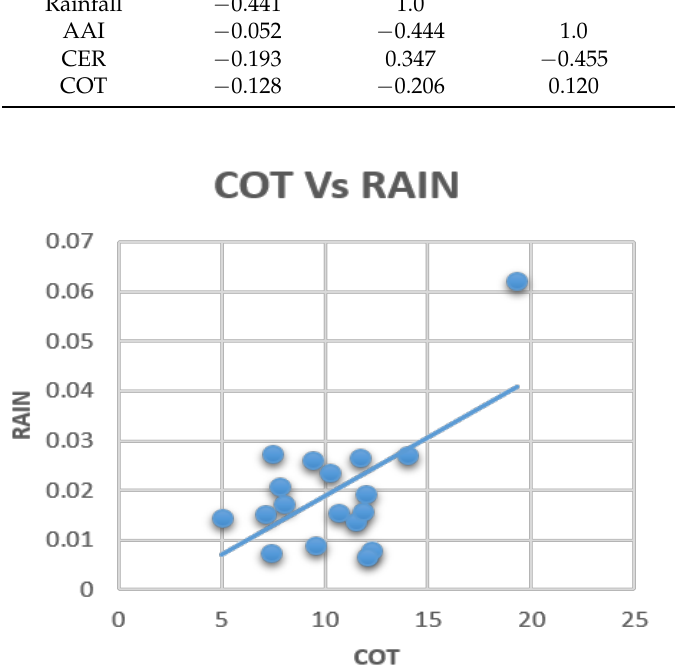
Figure 6. Scatter plot of COT vs. rainfall over Assab in July shows the correlation plot of highlighted bold values given in Table 5. Table 6. The correlation coefficient values between AOD, rainfall, AAI, CER, and COT over Nakfa in July 2001 and 2018.